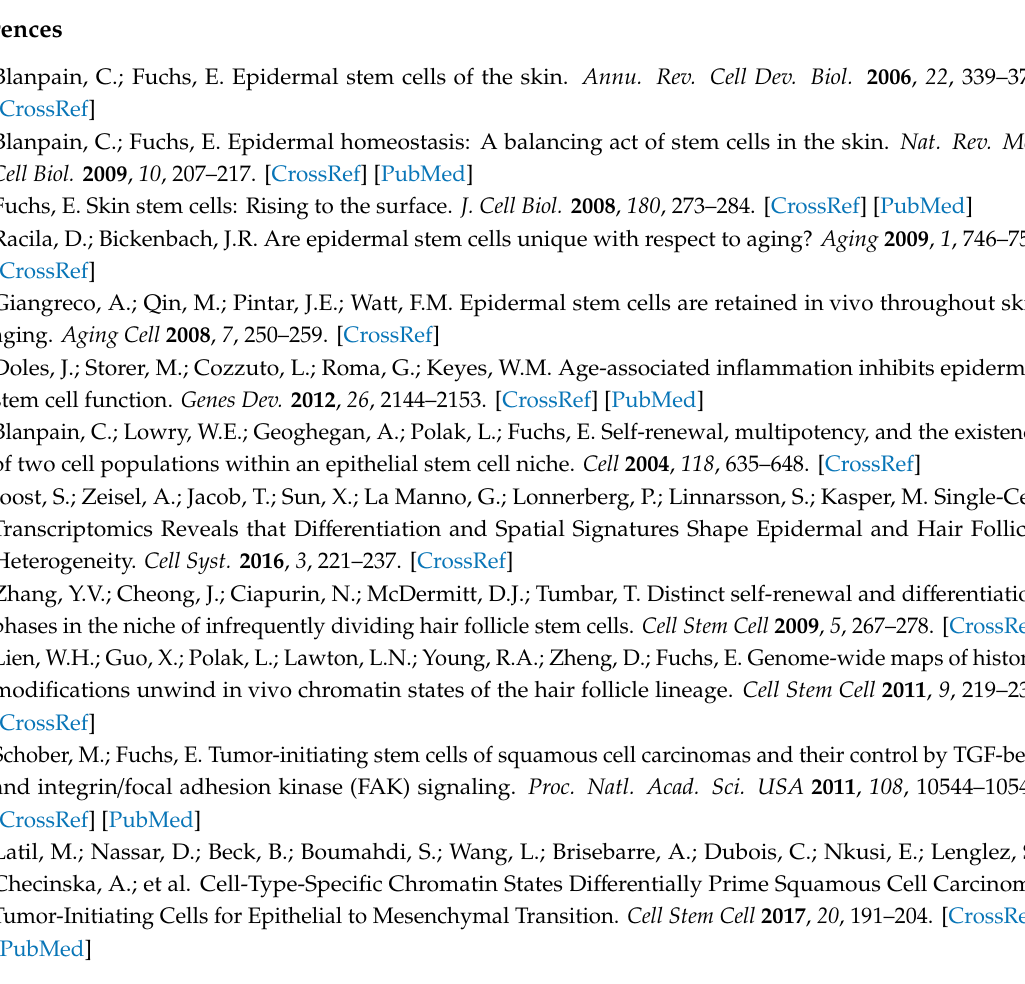
Supplementary Figure S1. Time-driven expression patterns in mouse SSCs. Combined gene ontology analyses of very early, early, middle, and late expression patterns shown in Figure 2. Bar orientation indicates positive (up) and negative (down) enrichment against baseline. Table S1. Age-regulated subsets of the transcriptome of SSCs. The peak position (1 = 18-day-old, 2 = 30-day-old, 3 = 2.5-month-old, 4 = 4-month-old, 5 = 6-month-old, 6 = 12-month-old), probeset, and gene symbol are indicated. Table S2. Intramodular connectivity of the epidermal stem cell dynamic expression patterns. The peak position (1 = 18-day-old, 2 = 30-day-old, 3 = 2.5-month-old, 4 = 4-month-old, 5 = 6-month-old, 6 = 12-month-old), the gene symbol, and the intramodular connectivity score are